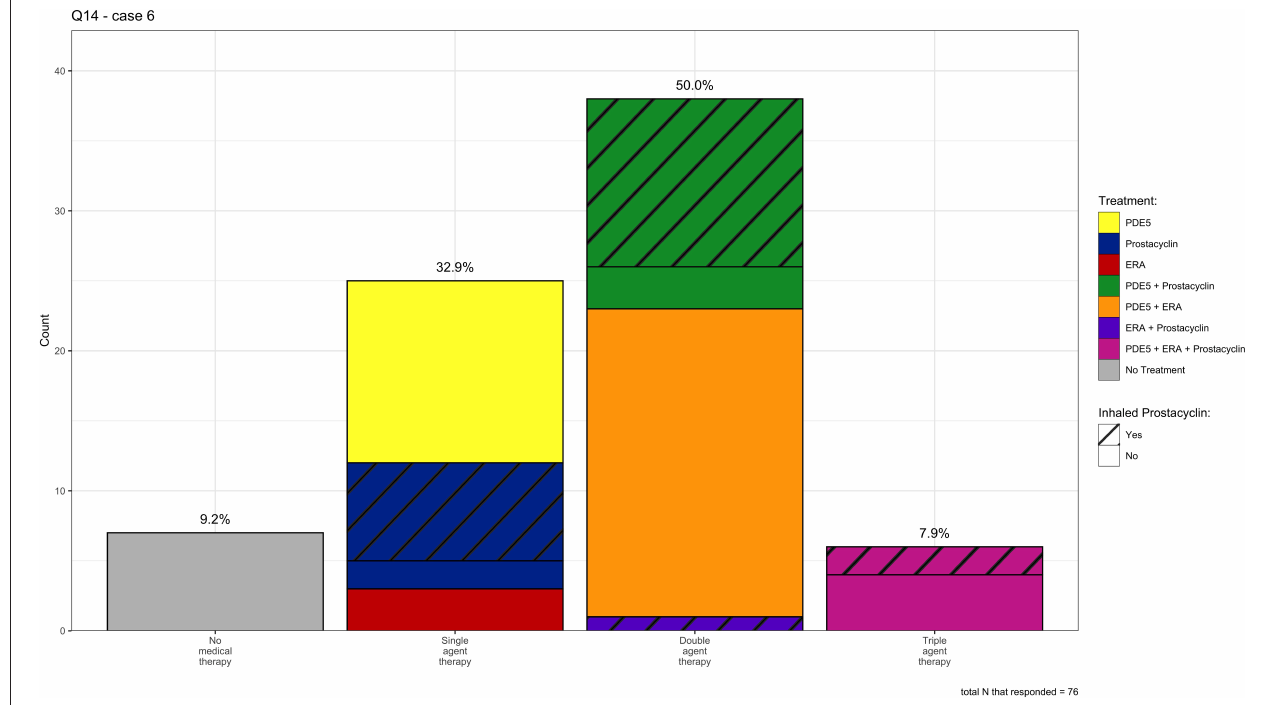
FIGURE 6 | Individual medication choices for case 6 (mild COPD and severe PH), N = 76.